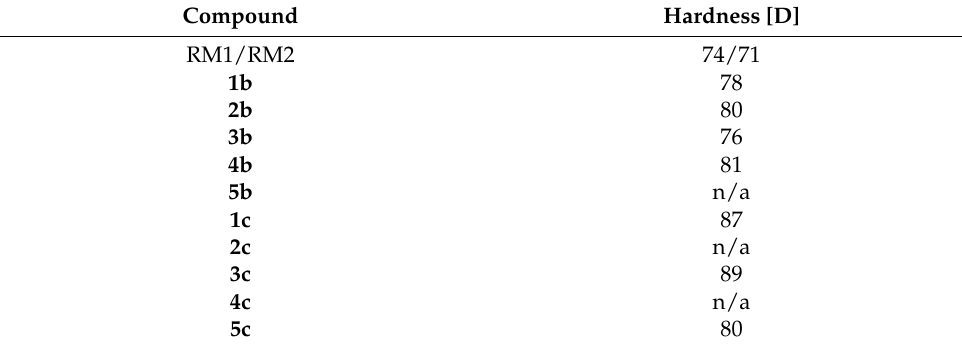
Table 4. Hardness measurements